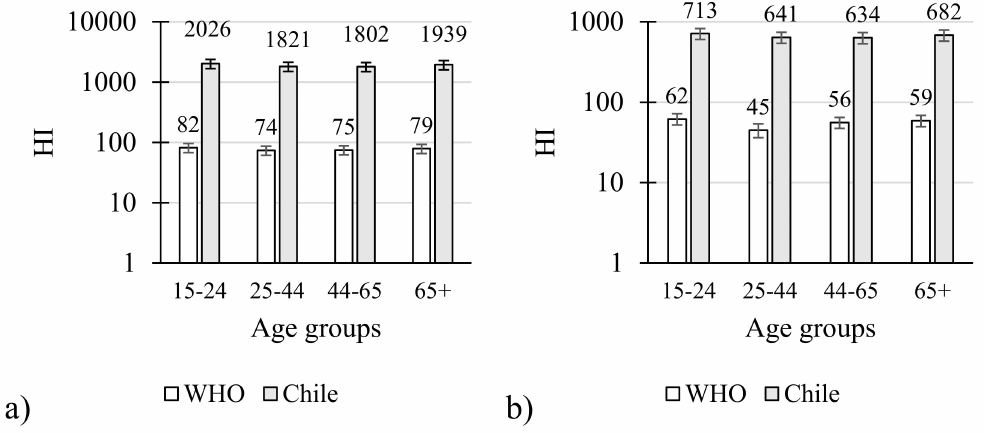
Figure 2. Hazard index for both models in all age groups: ( a ) lettuce; ( b )